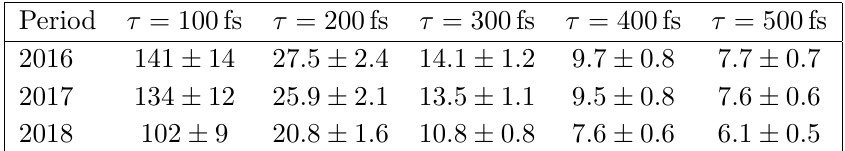
Table 3 . Single-event sensitivity (cid:11) in units of 10 (cid:0) 3 for di(cid:11)erent lifetime hypotheses of the (cid:4) 0 baryon for di(cid:11)erent data-taking periods. The uncertainties are due to the limited size of the simulated samples and the statistical uncertainties on the measured (cid:3) 0